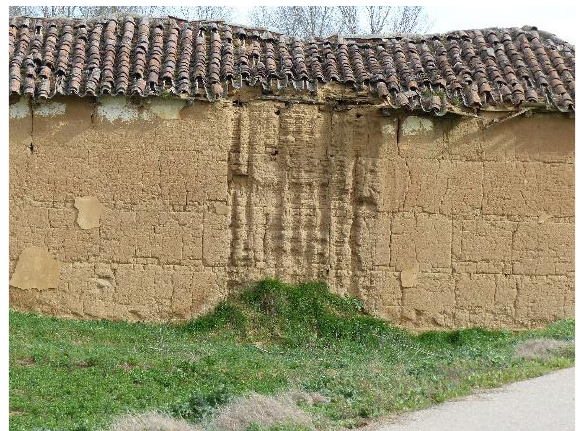
Figure 3. Washing of the wall caused by rain (Valderas,